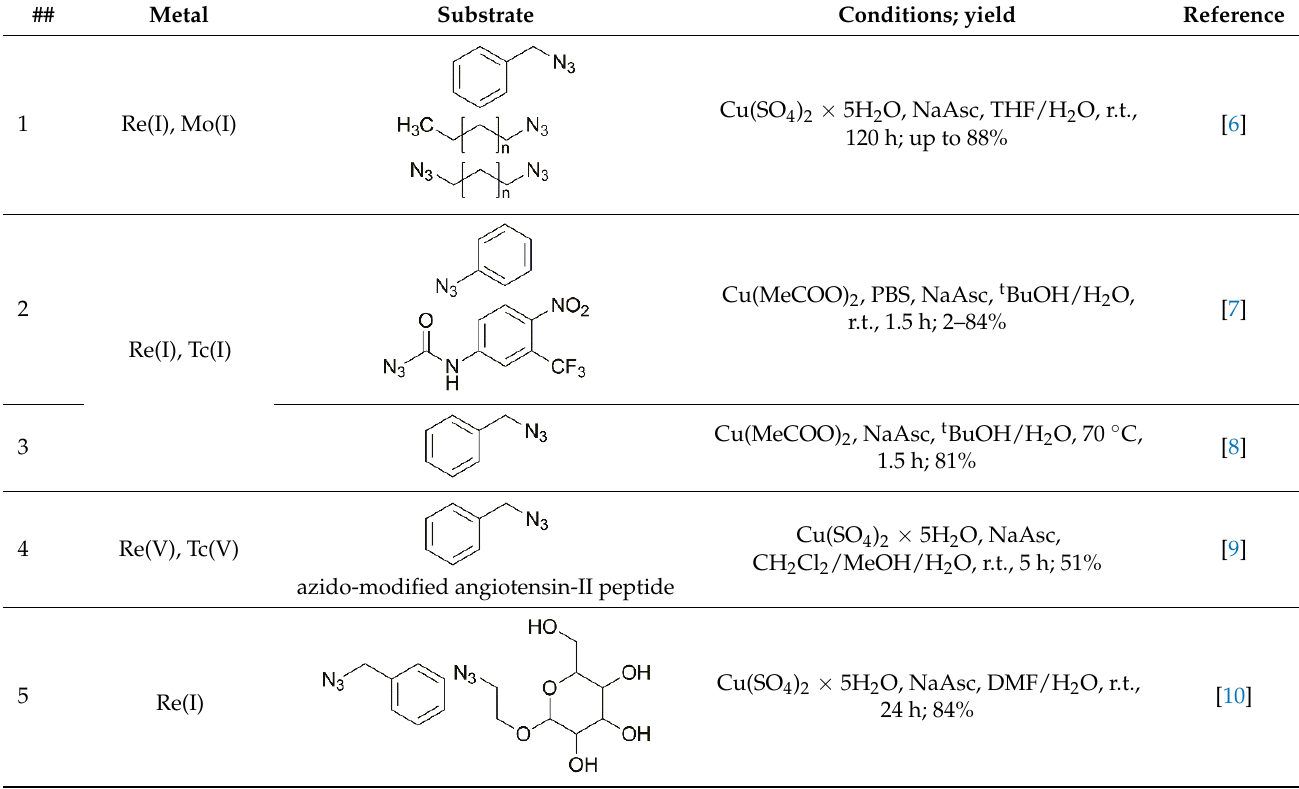
Ir(dfppy)2 P complexes with isotope pattern of key signals; Figure S16: 1 H NMR spectra of Pt1 X complexes; Figure S17: 1 H NMR spectra of Pt2 X complexes; Figure S18: 1 H NMR spectrum of Pt(btbpy) C complexes in aromatic region, DMSO-d 6 , RT; Figure S19: 1 H 1 H COSY NMR spectrum of Pt(btbpy) C complexes in aromatic region, DMSO-d 6 , RT; Figure S20: ESI + MS spectrum of Pt(dtbpy) C complex with isotope pattern of key signals; Figure S21: Molecular structure of Pt(dtbpy) C complex